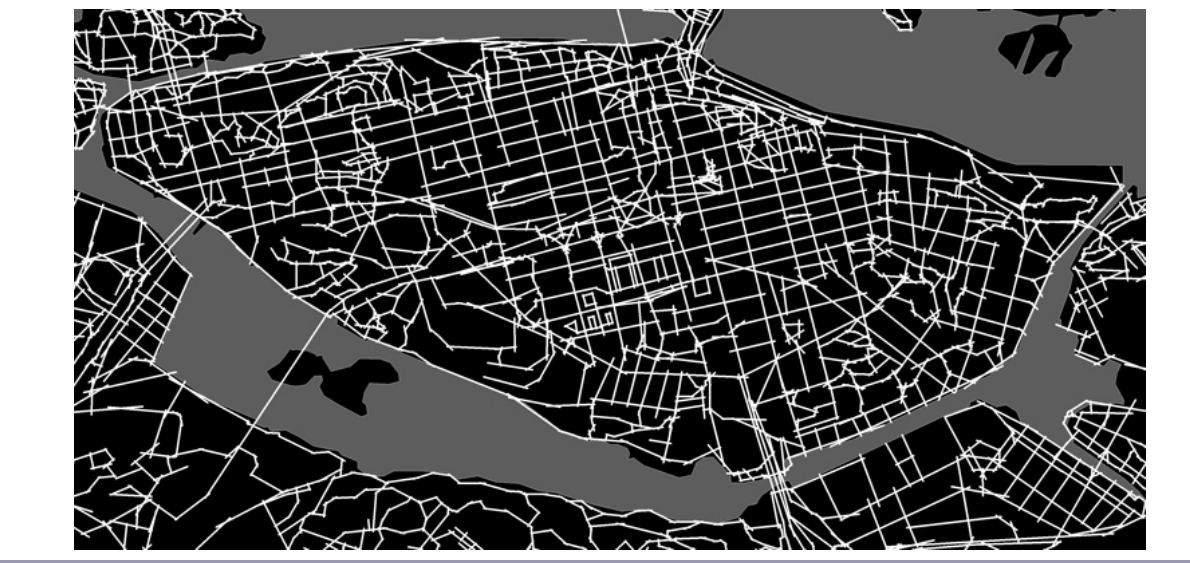
Fig. 3 . The axial map: a network representation of urban spatial form, constructed by the least amount of straight lines that cover all public open space, where the axial line represents a space that is possible to visually overlook and physically access for an experiencing person in the